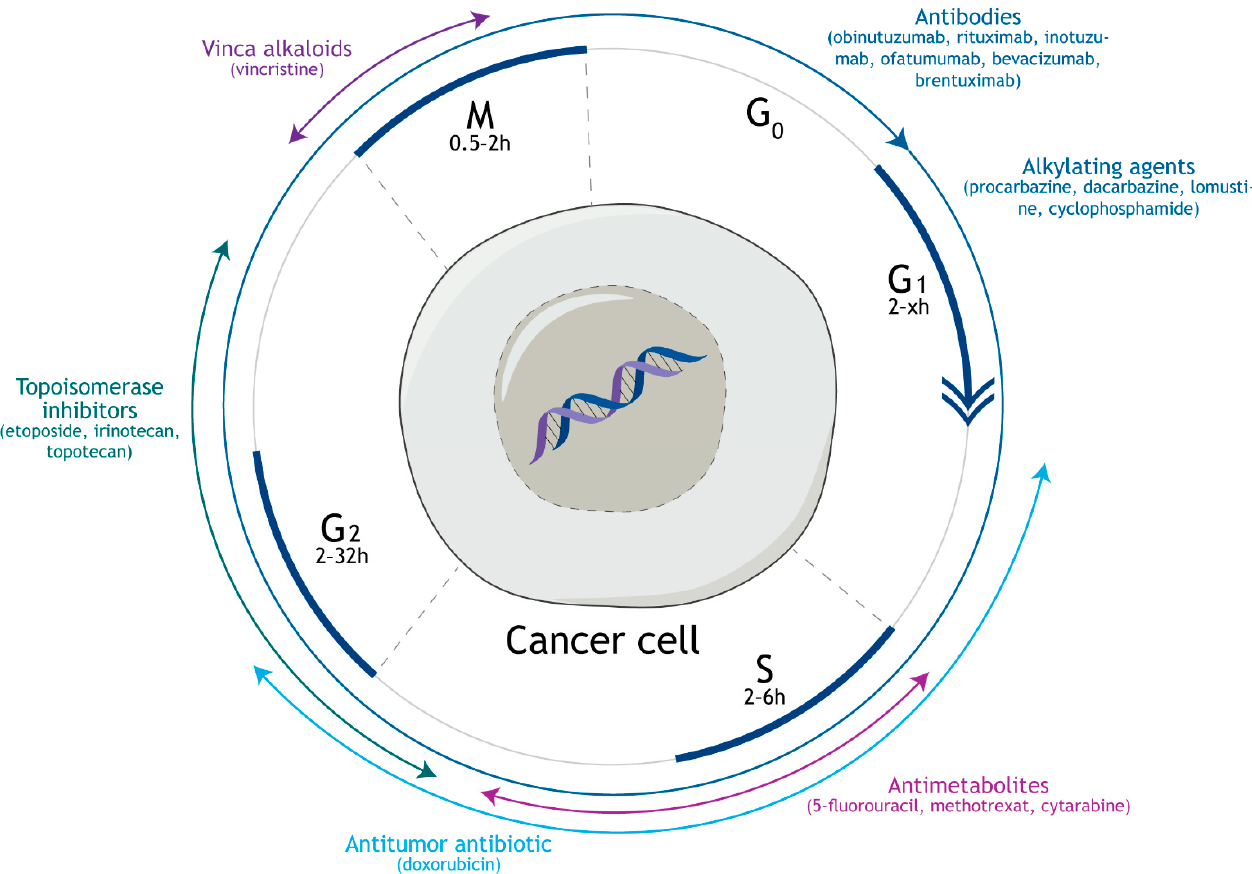
Figure 4. Phases of the cell cycle, which are affected by vincristine, and the compounds, which are used in combination with vincristine in cancer treatment.